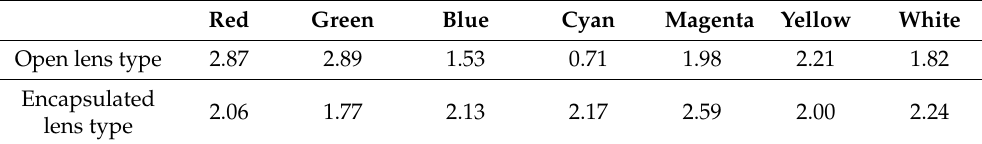
Table 2. Color reproduction accuracy using CIE 1976 Delta E color difference for open and encapsulated lens types.